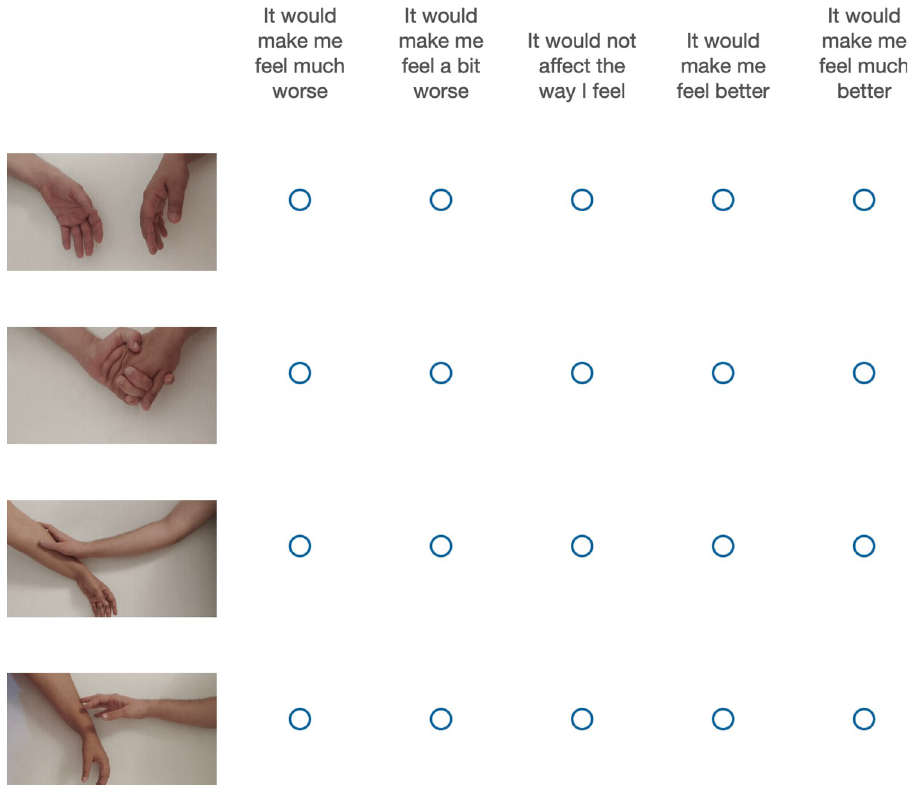
shows a still image from each video. Note that full palm stroking was only included in Studies 2 and